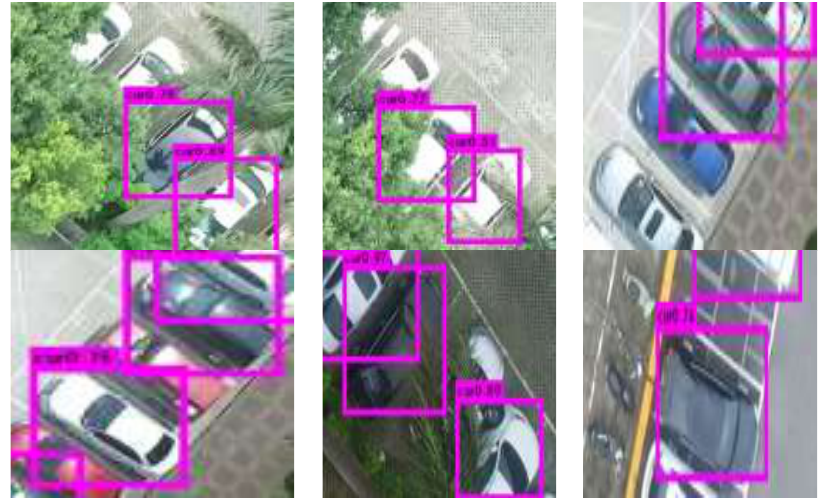
Figure 4. Omission Examples of the wrong multi-box suppression by NMS in YOLOv3.